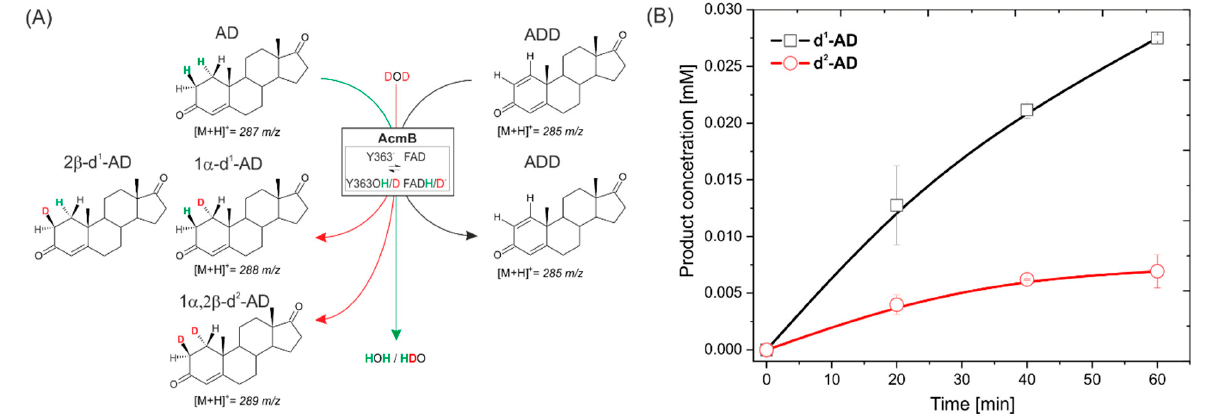
Figure 5. ( A ) Scheme of transhydrogenation catalyzed by AcmB between AD and ADD in D 2 O: ( B ) progress curve of the formation of deuterium-labelled AD. ( B ) progress curve of the formation of deuterium-labelled